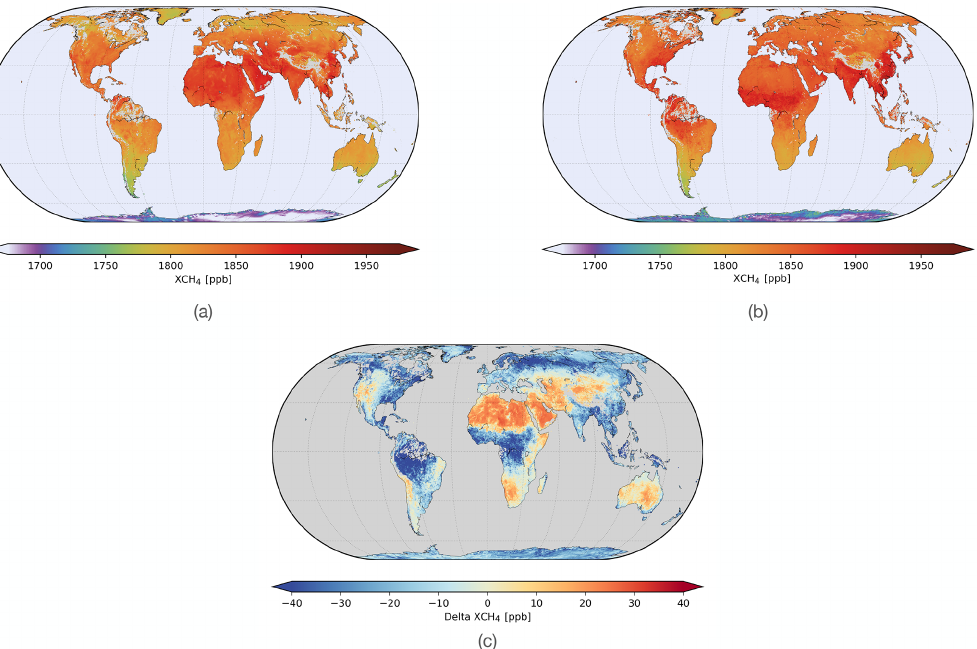
Figure 5. (a) Global TROPOMI XCH 4 distribution before correction, (b) after correction and (c) their difference (XCH 4 − XCH corr 2019 averaged in a cylindrical equal-area grid with 0 . 3 ◦ × 0 . 5 ◦ resolution at the Equator.